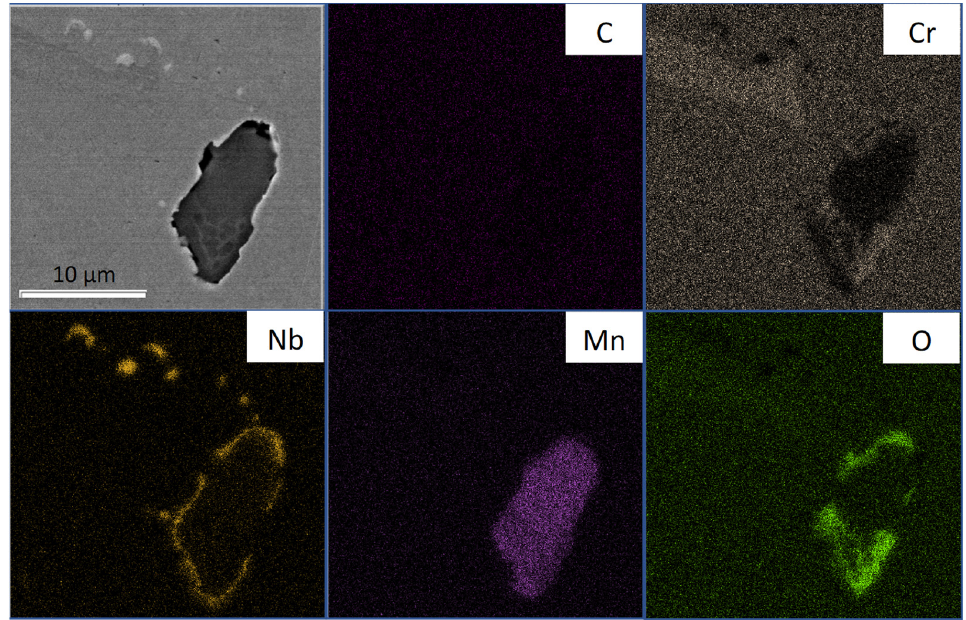
Figure 10. EDS elemental mapping of C, Cr, Nb, Mn, and O of complex inclusion.